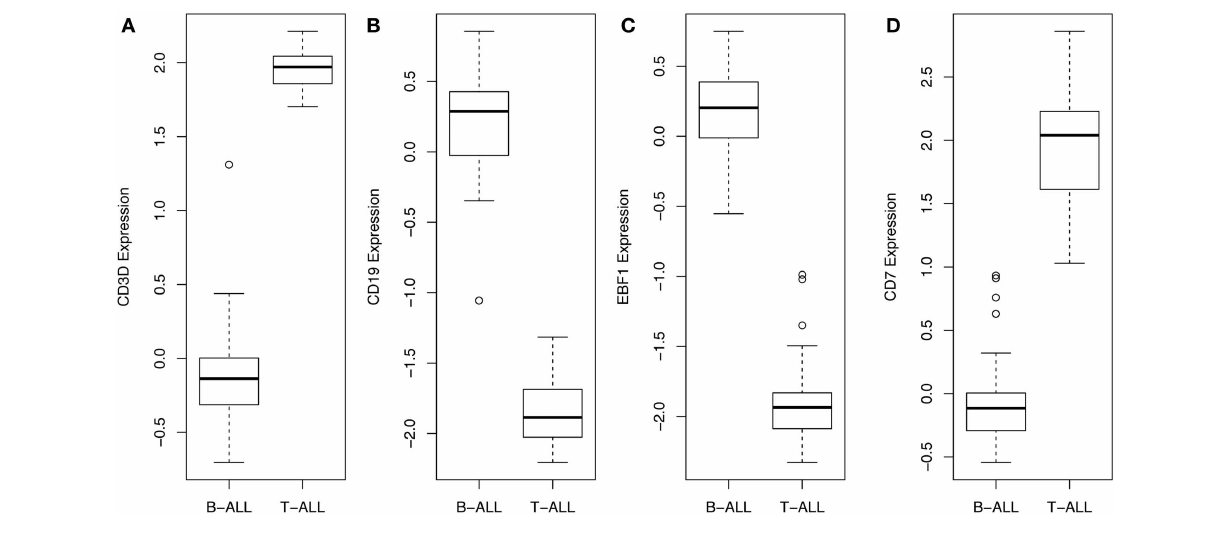
FIGURE 2 | Gene expression values, across all samples, for top scoring hits .The average and range of values of the top four genes are presented in this box and whisker plot, demonstrating that CD3D and